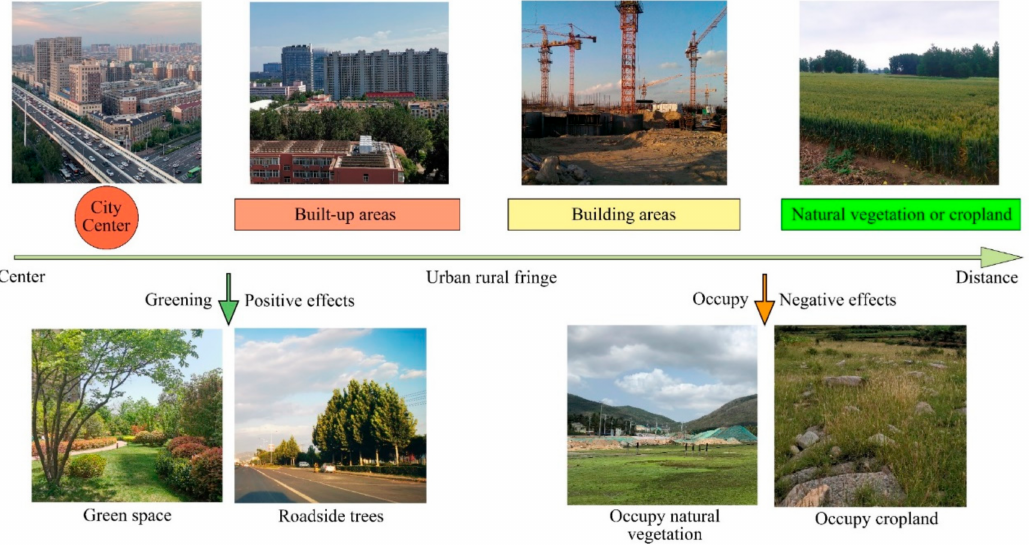
Figure 4. The effects of both urbanization and urban